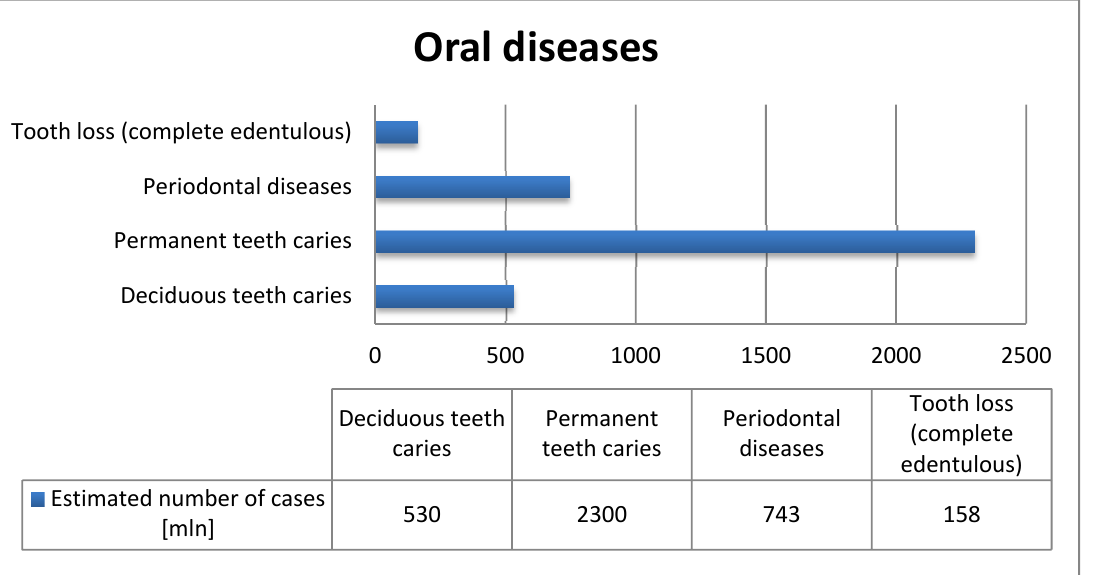
Figure 2. A graph showing the number of patients affected by oral diseases. Teeth caries is one of the most common illnesses in the world.